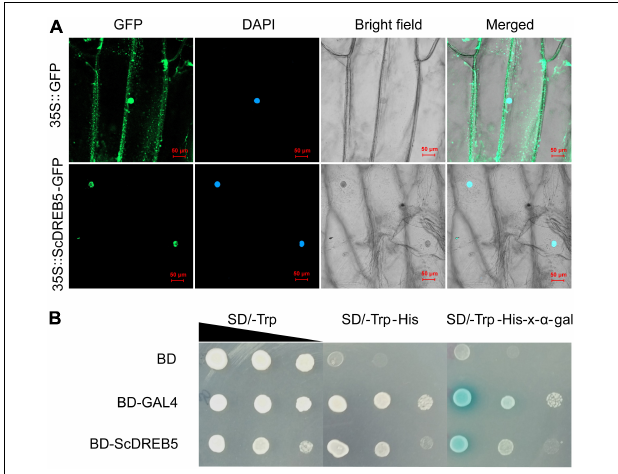
FIGURE 2 | Subcellular localization and transactivation activity analyses of ScDREB5 protein. (A) 35S:ScDREB5-GFP and 35S:GFP fusion protein were transiently expressed in onion epidermal cells. After DAPI staining, the transformed cells were examined using confocal microscopy to simultaneously capture GFP (488 nm) and DAPI (405 nm) signals. Left to right: green, GFP fluorescence; blue, nucleus stained with DAPI; bright field; merged, combined fluorescence from GFP and DAPI (scale bar: 50 µ m). (B) The transcriptional activation ability of ScDREB5 was examined using the yeast one-hybrid assay. Yeast cells Y2H expressing the fusion proteins were cultured and adjusted to an OD600 of 2.0, then series diluted and dropped with 2 µ L on nutritional selective mediums SD/-Trp, SD/-Trp/-His and SD/-Trp/-His + x- α -gal. Yeast cells expressing pGBKT7-BD empty vector served as the negative control and those expressing pGBKT7-GAL4 served as the positive control. Photos were taken after incubating at 30 ◦ C for 2–4 d.